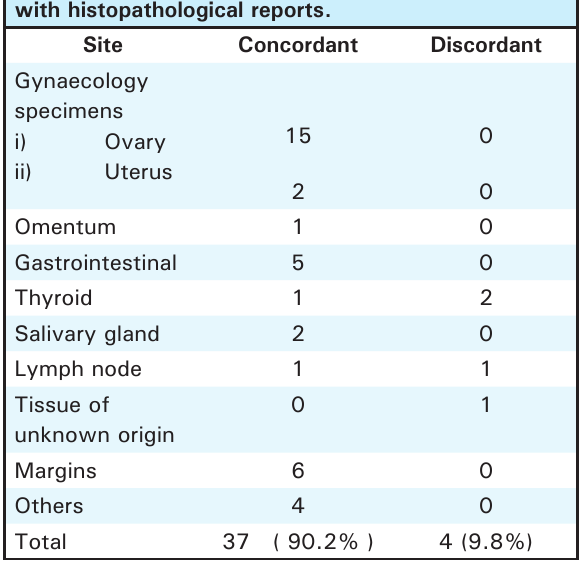
Table 3. Neoplastic vs non neoplastic lesions (total number of cases).